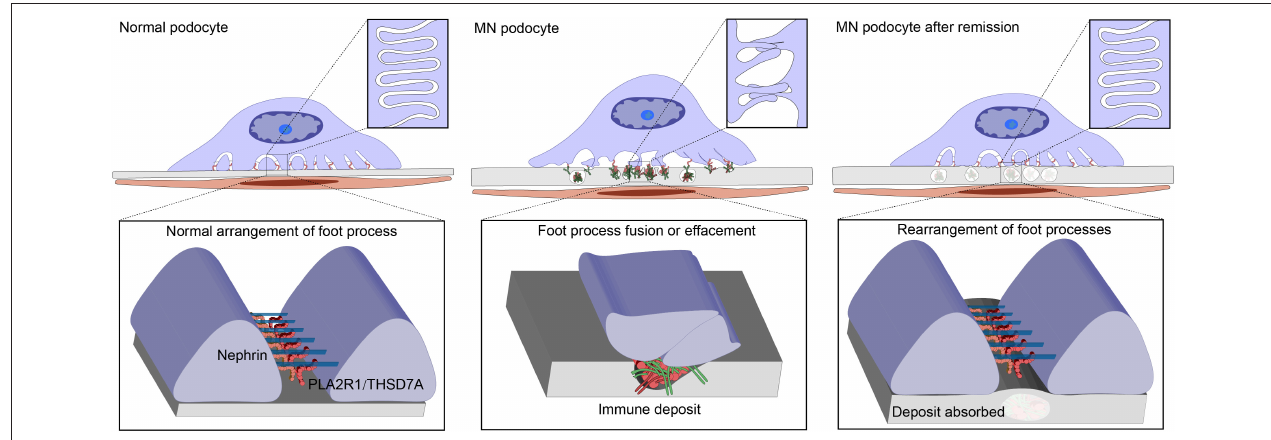
FIGURE 4 | Changes of Podocyte morphology under various conditions. M-type receptor for secretory phospholipase A2 (PLA2R1) or thrombospondin type-1 domain-containing 7A (THSD7A) potentially maintain the slit diaphragm or the adherence of podocytes to glomerular basement membrane (GBM), involved in the normal arrangement of the foot processes. Anti-PLA2R1/THSD7A antibodies bind podocytes forming the immune deposits and resulted in thickness of GBM and morphological changes of podocytes, including cell body enlargement and foot process effacement. Under the damage degree that does not exceed the self-repairing ability threshold, the podocytes gradually goes toward self-healing with the gradual relief of pressure, recovering the original structure, and function. Foot processes rearrange and immune deposits are absorbed by GBM, and finally is the restoration of normal filtration capacity and proteinuria remission.